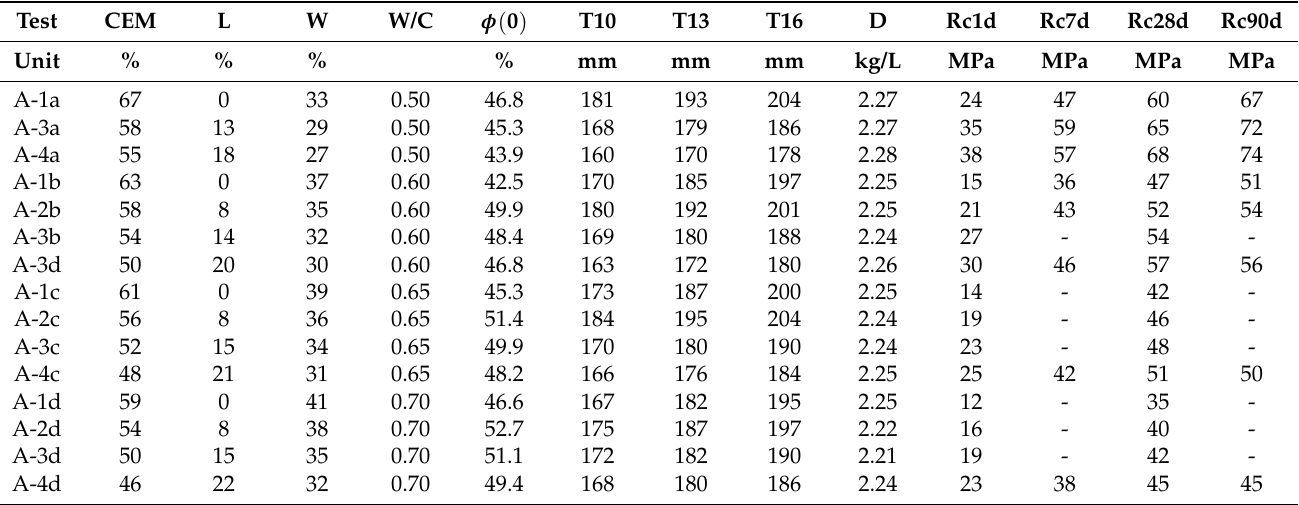
Table 6. Formulations of the pastes prepared with different contents as mass percentage of the total paste mix for the cement (CEM), GGC (L) and water (W) given as mass percentage. The mixes are prepared at four different water-to-cement ratios. The initial porosity calculated φ ( 0 ) is given for each mix. Corresponding slump tests after 10, 13, 16 shocks (T10, T13 and T16), the medium density